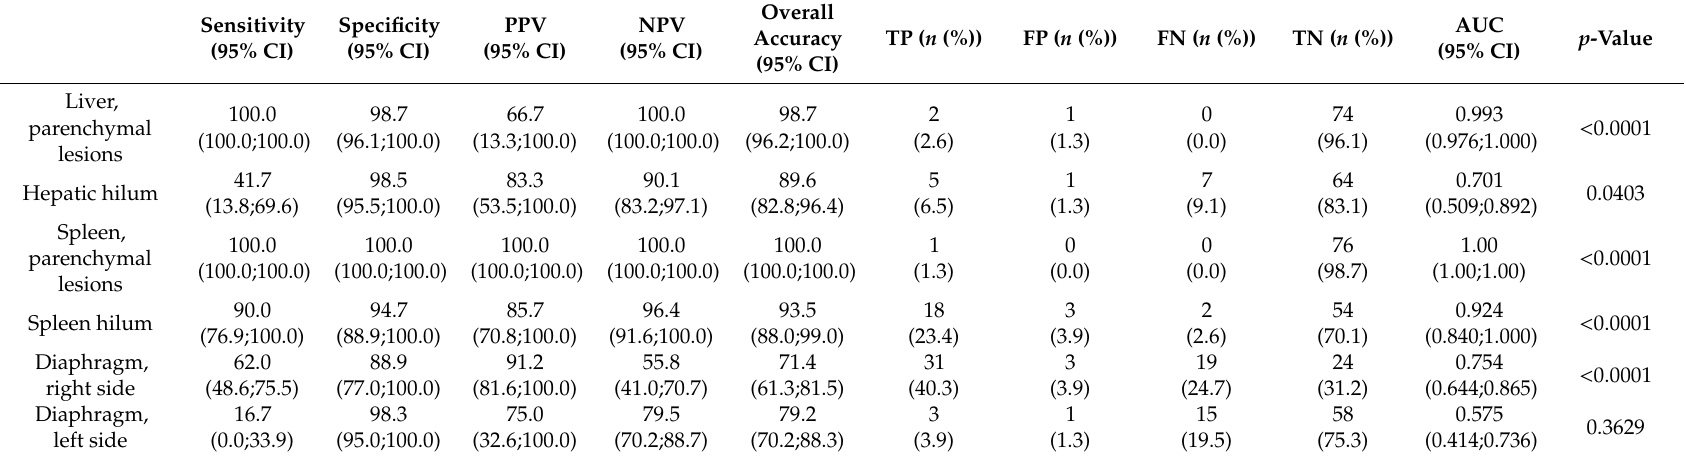
Table 1. Predictive parameters of preoperative combined transabdominal and intercostal upper abdomen ultrasonography for surgical-pathological findings in the subdiaphragmatic